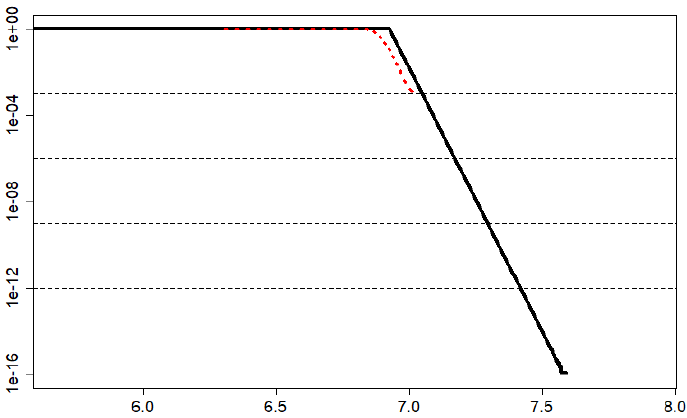
Figure 2. Example of probabilistic Worst-Case Execution Time (pWCET)